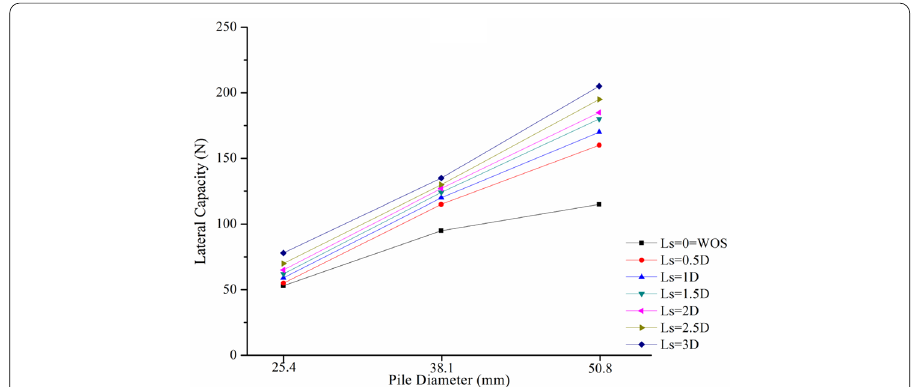
Fig. 9 Lateral capacity of pile with varying depth of socketing for pile having embedded depth L e 800 mm